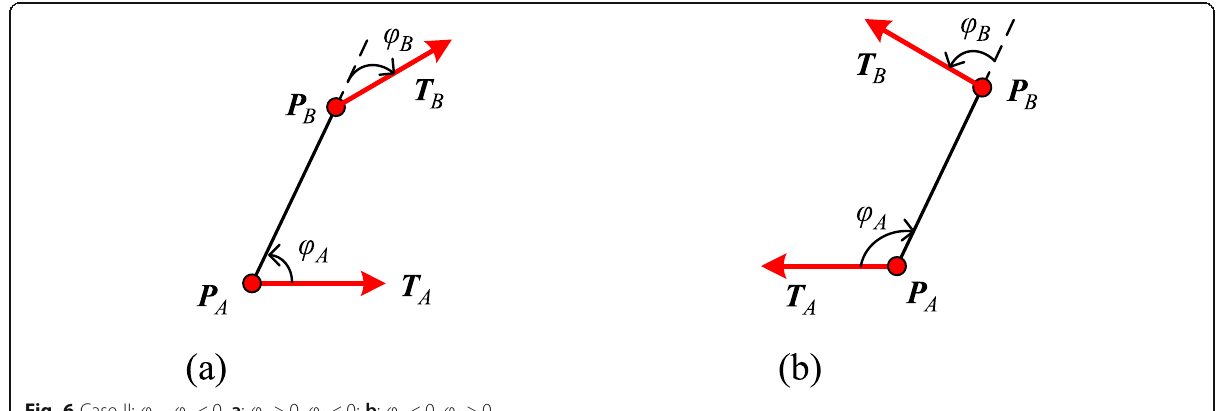
Fig. 6 Case II: φ A ⋅ φ B < 0. a : φ A > 0, φ B < 0; b : φ A < 0, φ B > 0